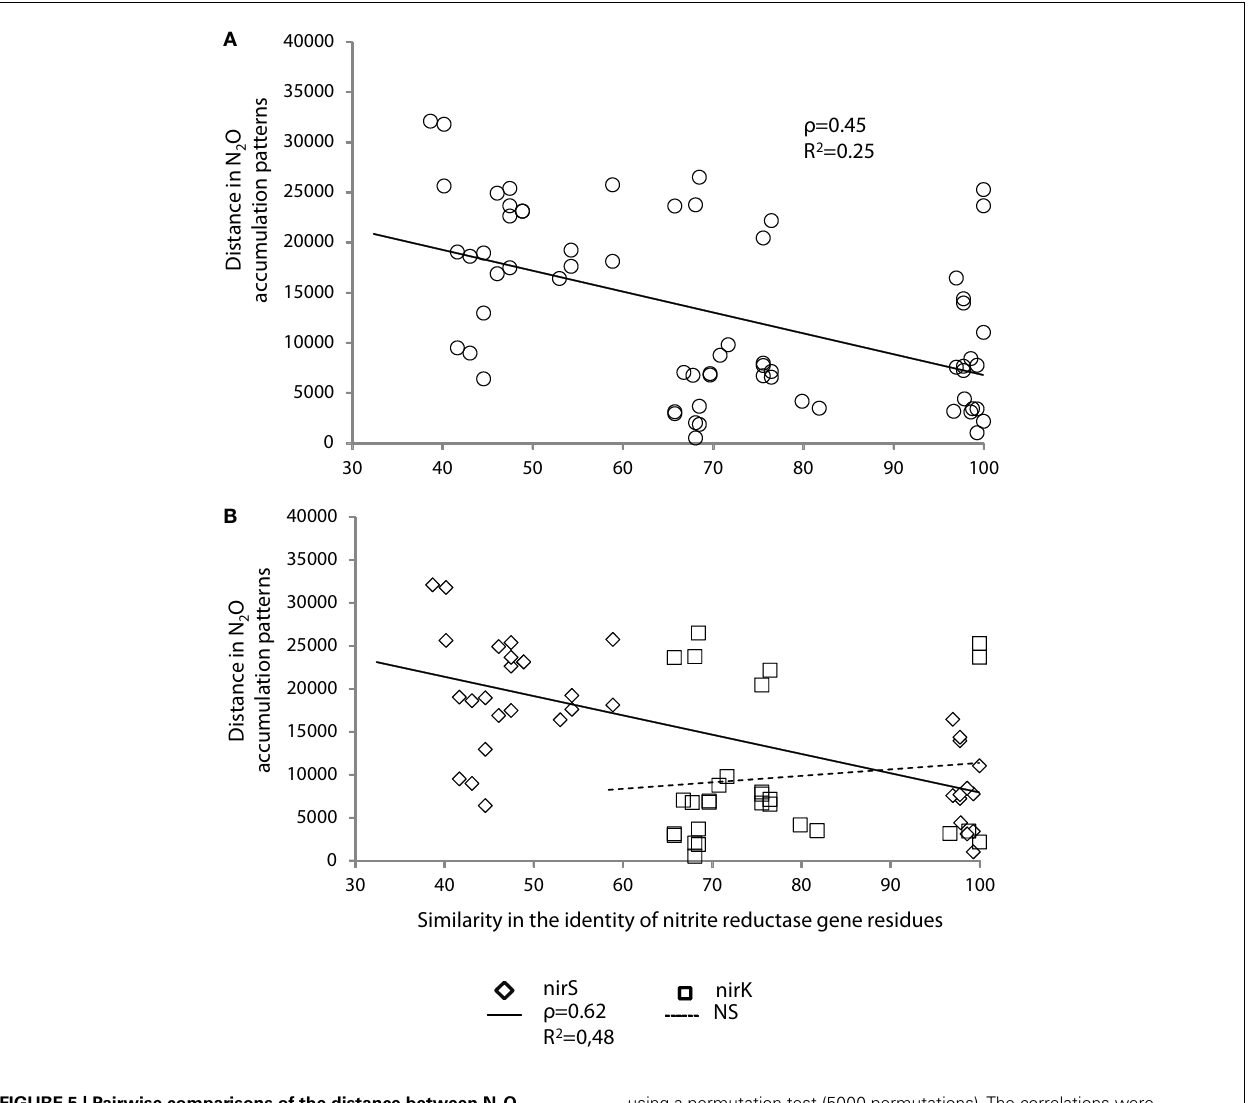
FIGURE 5 | Pairwise comparisons of the distance between N 2 O accumulation patterns and the similarity in the identity of nitrite reductase residues (A) considering nirK- and nirS- harboring bacteria simultaneously or (B) distinguishing nirK- and nirS- harboring bacteria. Comparisons were performed using a non-parametric form of Mantel test and Spearman coefficient ( ρ ). Significance level was checked